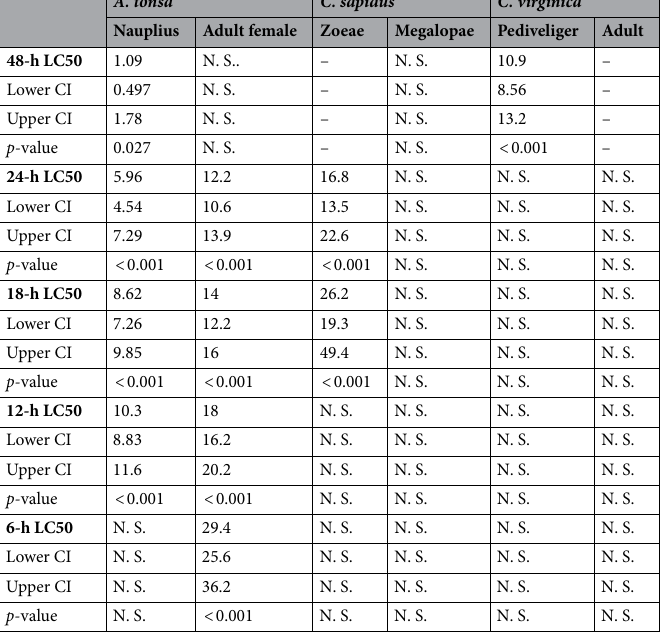
Table 1. LC50s (% v/v) for different organisms at different time points, along with their associated confidence intervals as determined from Probit analysis. (N. S. = Not significant, p > 0.05; “–“ Not